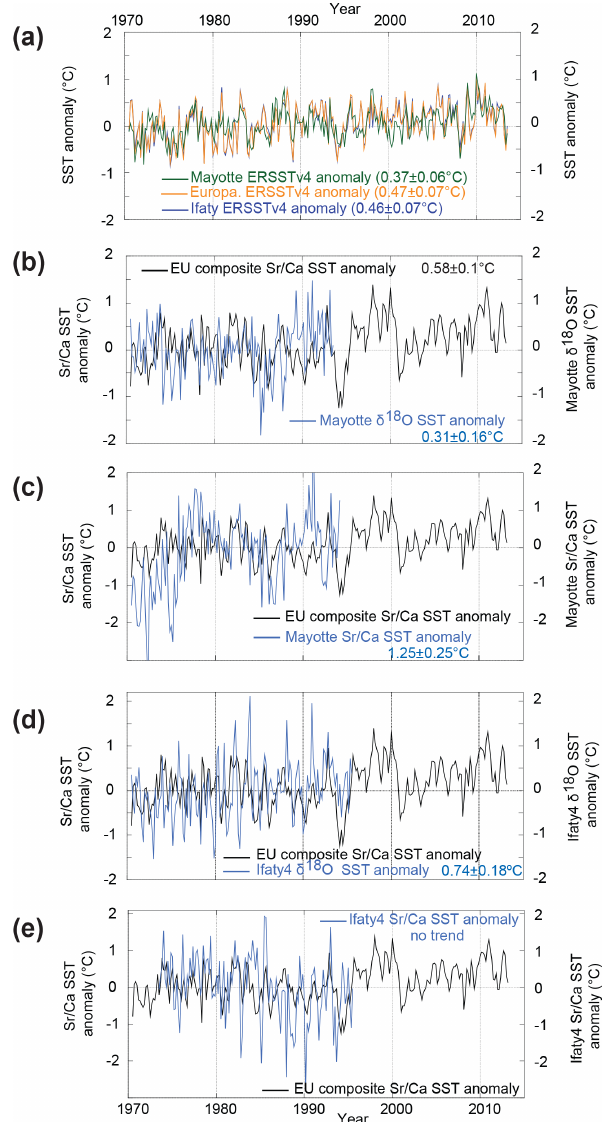
Figure 9. Regional comparison of Mozambique Channel ERSSTv4 anomalies for Mayotte (green), Europa (orange), and Ifaty, Mada- gascar (blue) (a) , with linear warming trends in brackets. EU Sr / Ca SST composite anomaly compared with (b) Mayotte δ 18 O SST anomaly (blue), (c) Mayotte Sr / Ca SST anomaly (blue), (d) Ifaty δ 18 O SST anomaly (blue), and (e) Ifaty Sr / Ca SST anomaly (blue). Anomalies were calculated for the 1973 to 1993 reference period. Linear warming trends indicated in (b) – (e) for proxy–SST for in- dividual record length with EU composite Sr / Ca SST anomaly only indicated once in panel (b) . Proxy data taken from Zinke et al. (2004,